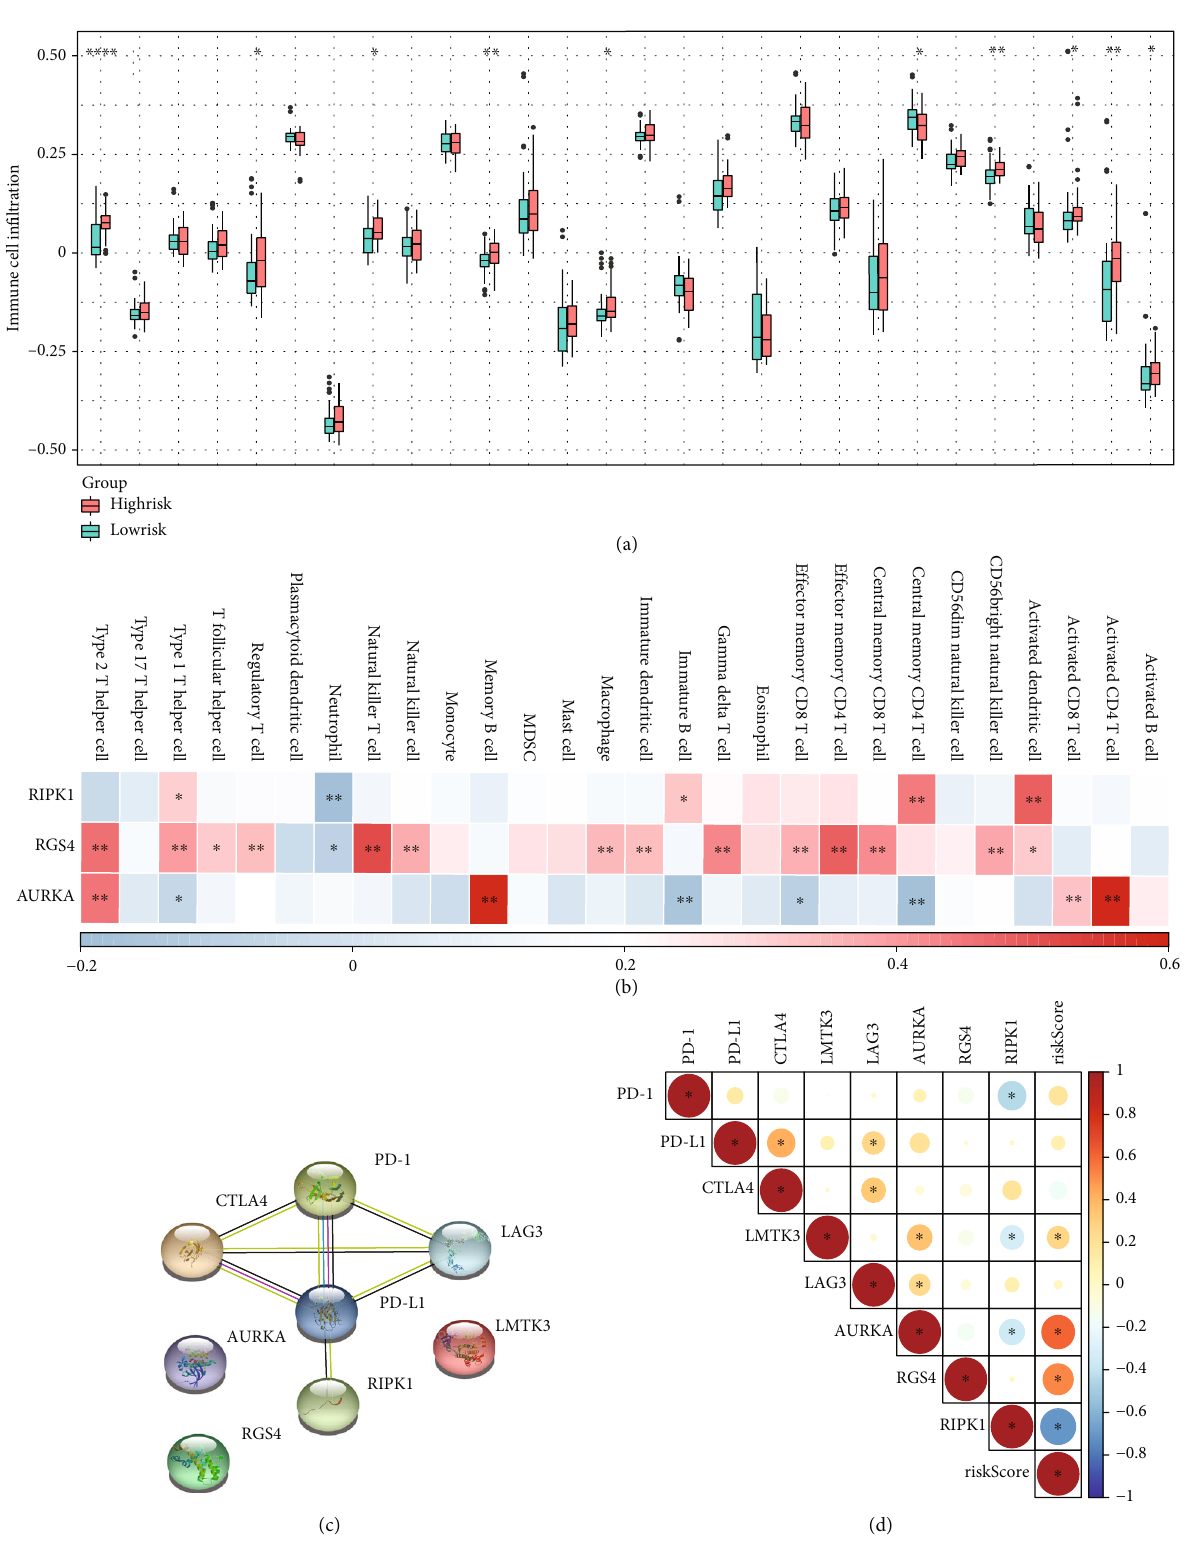
Figure 5: Assessing the potential of the gene signature in immunotherapy. (a) Di ff erence in 28 kinds of immune cell in fi ltration between high- and low-risk group ( ∗ P < 0 : 05 ; ∗∗ P < 0 : 01 ; ∗∗∗ P < 0 : 001 ; ∗∗∗∗ P < 0 : 0001 ). (b) The correlation between 28 kinds of immune cells and 3 key genes (the x -axis label is the same as (a)). (c) PPI network constructed by 5 kinds of immune checkpoint molecules and 3 key genes. (d) Correlation immune checkpoints between riskScore and immune checkpoints/key genes (blue, negative correlation; red, positive correlation; ∗ P < 0 : 05